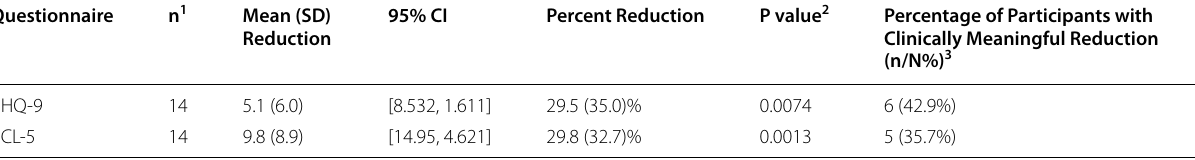
1 Excludes one participant with score over 2 standard deviations above the mean 2 Two-tailed, paired t-test 3 Defined as at least a 5-point decrease for PHQ-9 and at least a 10-point decrease for PCL-5